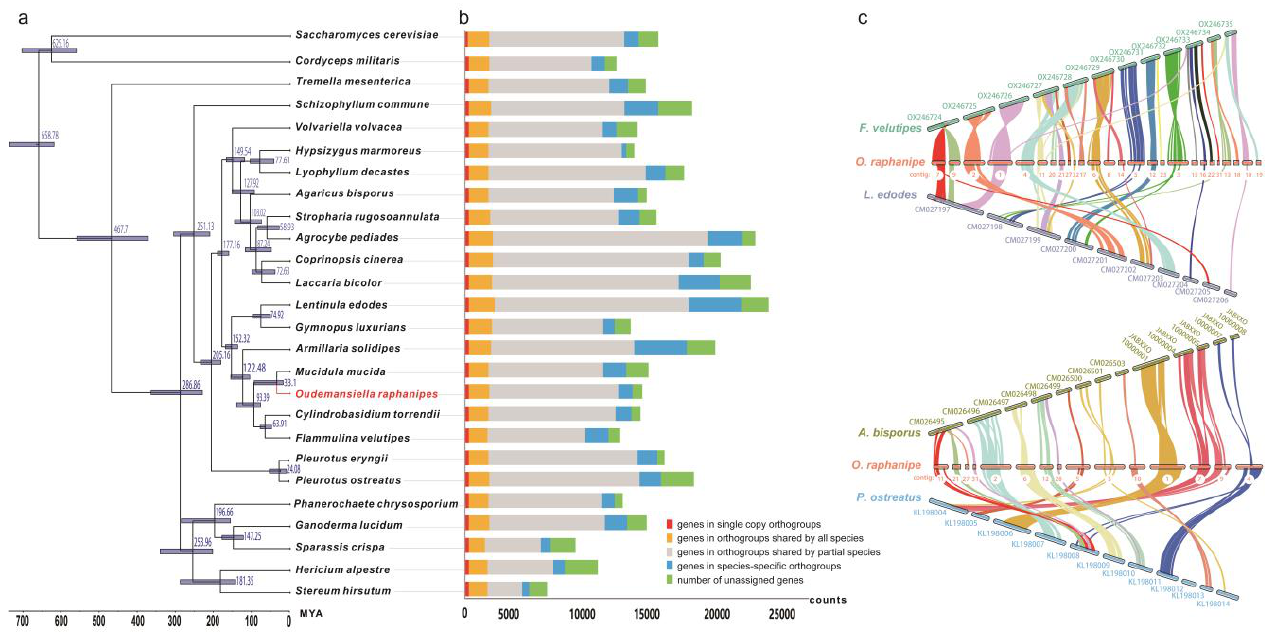
Figure 3. Evolutionary and comparative genomic analysis of O. raphanipes . ( a ) Phylogenetic tree was constructed based on 309 single-copy orthologs from O. raphanipes and 25 other fungal species (23 Basidiomycetes and 2 Ascomycetes ) using OrthoFinder. Divergence timings were indicated using transparent blue bars at the internodes with 95% highest posterior density using MYA (million years ago) as a unit at the x-axis. Single-copy orthologs are defined as orthologs that were present as a single-copy gene in all 26 species. ( b ) Number of different orthologous gene types was calculated in each fungal species and indicated with different colors. ( c ) The genome collinearity among O. raphanipes , F. velutipes and L. edodes (upper), as well as O. raphanipes , A. bisporus and P. ostreatus (lower). Each line connects a pair of collinearity blocks between two